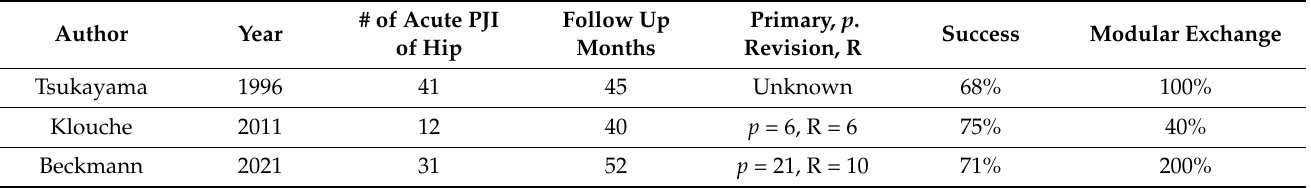
Table 6. Studies showing elimination/control of infection with no further DAIR/I and D for Infection.